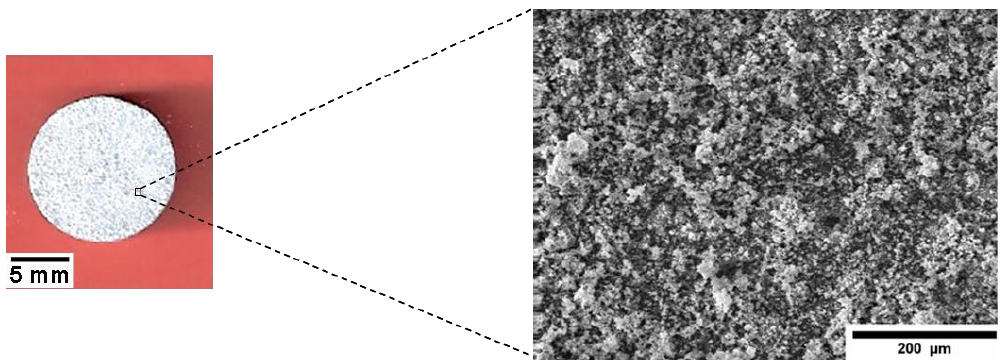
Figure 11. Photograph and SEM image of a calcium phosphate coating electrodeposited with pulsed current at 15 mA cm −2 . Reprinted with permission from Ref. [72]. Copyright 2010 Wiley.